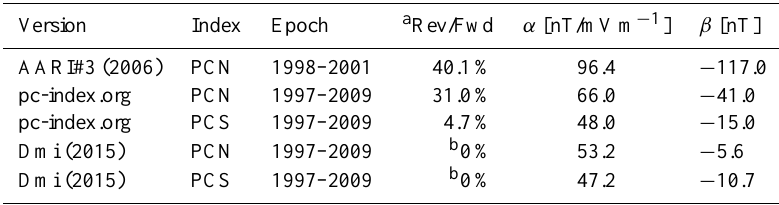
Table 2. Ratio of strong reverse to forward convection intensities and extreme values of slope ( α) and intercept ( β) coefficients for various index versions and